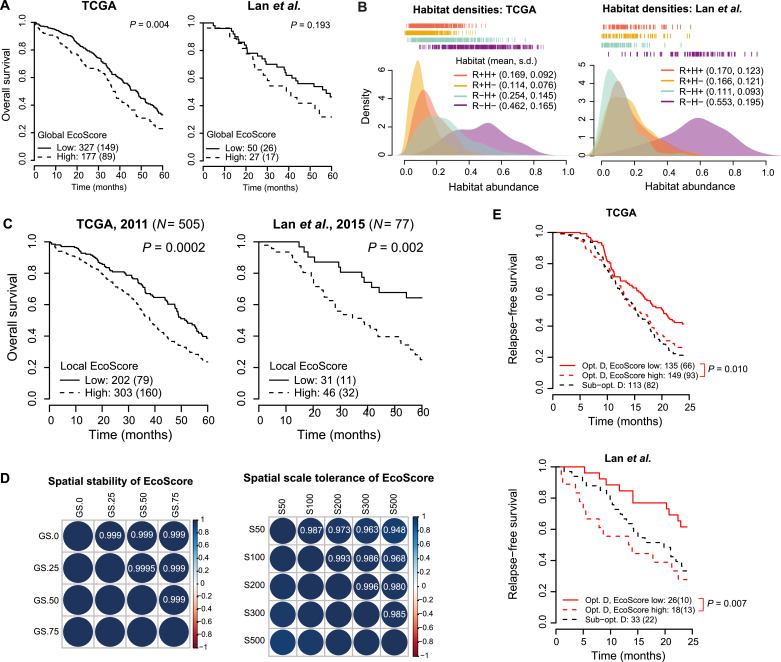
Assessing the prognostic value and stability of EcoScore. (A) Kaplan-Meier plots display the prognostic value of global EcoScore, defined by the mean ratio of distance to the nearest lymphocyte and stromal cell hotspots for a cancer habitat, for 5-year overall survival in two independent cohorts of HGSOC patients. Numbers outside parentheses indicate group size and numbers inside parentheses indicate deaths. (B) Kernel density plots show the distribution of abundances of the four ecological habitats in the TCGA (left) and Lan et al. (right) cohorts. Mean and standard deviation (s.d.) of each distribution are given in brackets in the legends. In both cohorts, the peak of the R − H− distribution is shifted to the right of the others and the s.d. of this distribution is highest. (C) Kaplan-Meier plots display the prognostic value of local EcoScore, defined by the balance of tumour-promoting habitats against tumour-inhibiting habitats, for 5-year overall survival in two independent cohorts of HGSOC patients. Numbers outside parentheses indicate group size and numbers inside parentheses indicate deaths. (D) Top: Heatmap illustrating the correlations between local EcoScore computed for each sample in the validation cohort following grid shifts of 0 (original), 25, 50, and 75 μm. Each square in the grid is 100 μm. Bottom: Heatmap illustrating the correlations between EcoScore computed for each sample in the validation cohort using grid square sizes of 50, 100 (original), 200, 300, and 500 μm. The resulting values of EcoScore are highly correlated. (E) Kaplan-Meier curves display stratification for overall survival using local EcoScore of patients who had optimal debulking surgery (Opt. debulking, red curves) in the discovery and validation cohorts. Patients who had optimal debulking surgery and a high tumour EcoScore had a statistically similar overall survival probability compared to patients who had sub-optimal debulking (Sub-opt. debulking, black dashed curves).